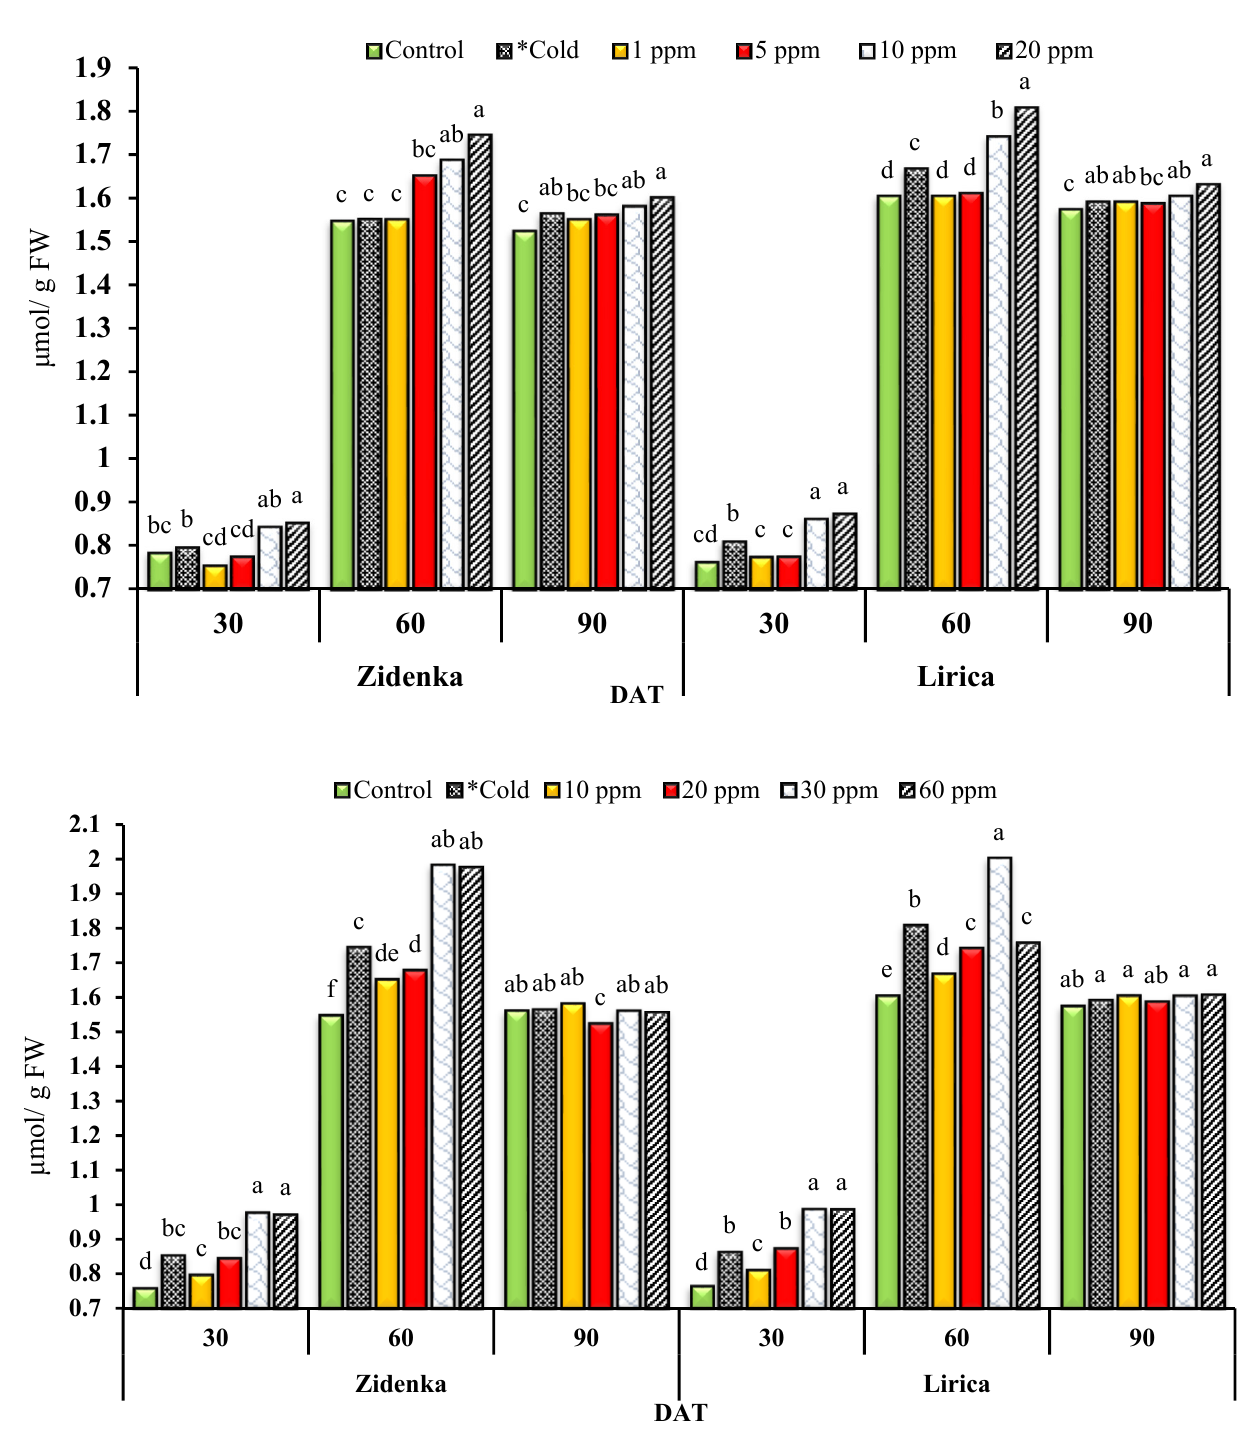
Figure 2. Effect of seed soaking with different ozonated water concentrations and cold pretreatments on the proline content of two pepper hybrids 30, 60, and 90 days after transplanting during the 2017/2018 ( upper figure) and 2018/2019 ( lower figure) seasons. Columns labeled with a lowercase letter are not significantly different according to Duncan’s multiple range test at 0.05 levels for the same sampling date in each season and each hybrid separately. * Cold stress treatment was performed at 4 ◦ C for 36 h. Ozonated water was applied as seed soaking. The average value of three biological and three technical replicates is reported.